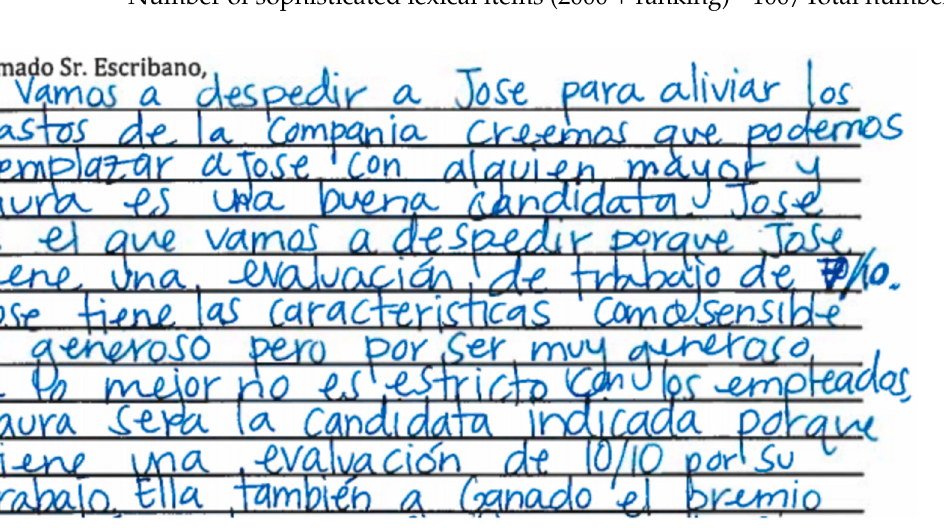
Figure 1. Sample letter (HL–HL pair, SCMC mode). “Dear Mr. Escribano, we are going to lay off Jose to alleviate the expenses of the company. We believe that we can replace Jose with someone older and Laura is a good candidate. Jose is the one that we will lay off because Jose has a work evaluation of 7/10. Jose has the characteristics of being sensitive and generous but for being so generous, maybe he is not strict with the employees. Laura will be the suitable candidate because she has an evaluation of 10/10 for her work. She has also won the prize”.